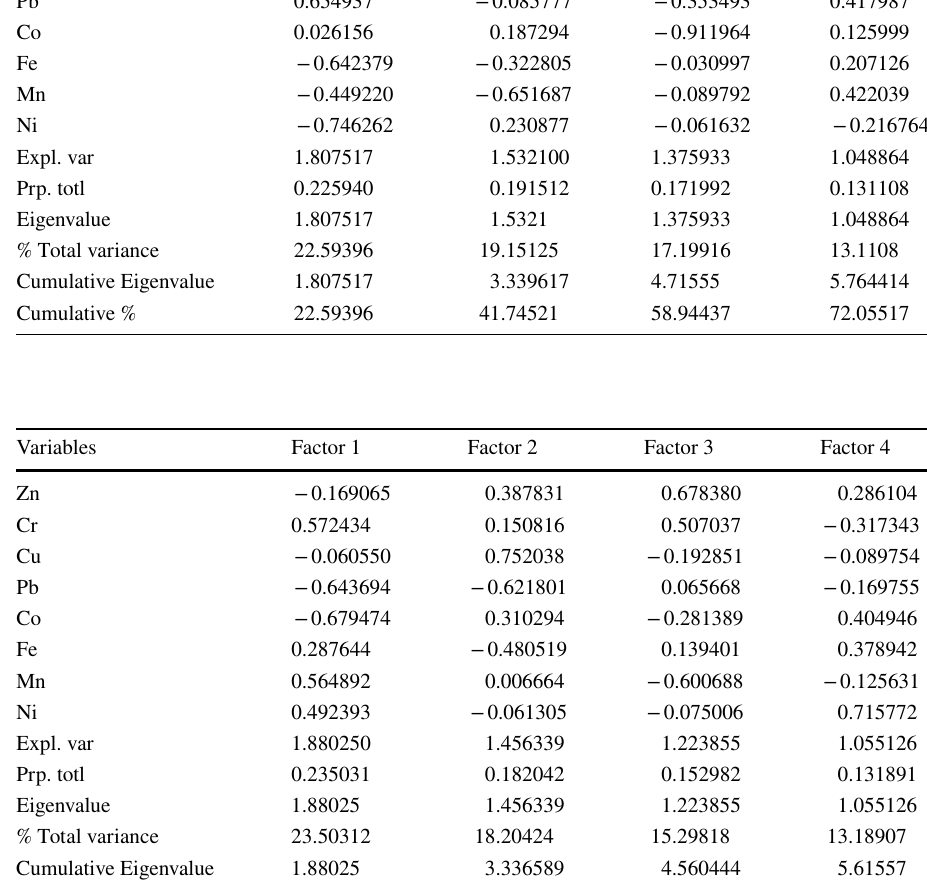
the Archaean formation groundwater samples (varimax rotated)